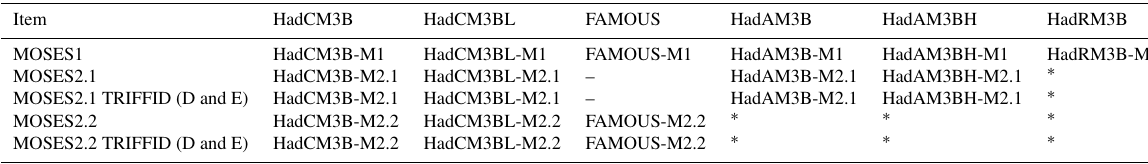
Table 2. Availability of alternative land surface schemes.